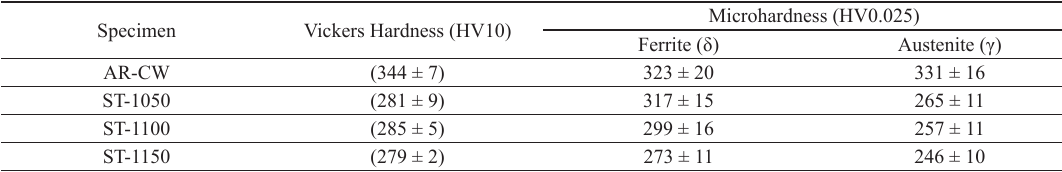
Table 4. Vickers hardness and microhardness of ferrite and austenite phases.